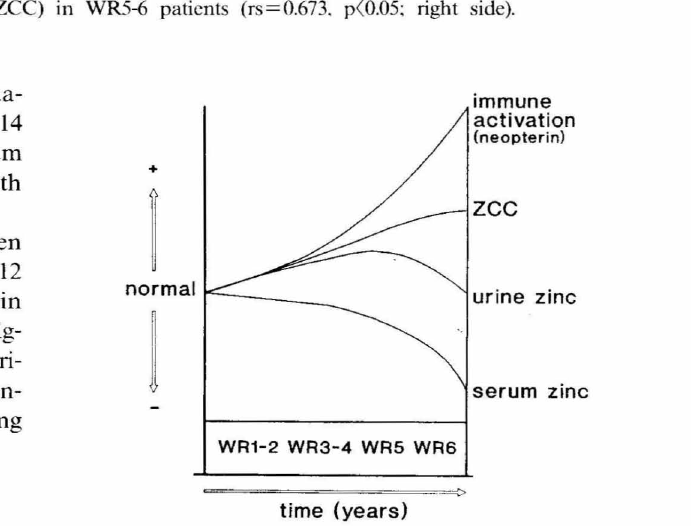
Fig.l: Correlation between urinal)' neopterin and zinc levels in WR6 .patients (rs=0.748. p(0.05; left side) and between urinal)' ·l<.'opterin concentrations and zinc c1earence coefficients (ZCC) in WR5-6 patients (rs=0.673. p(0.05: right side).